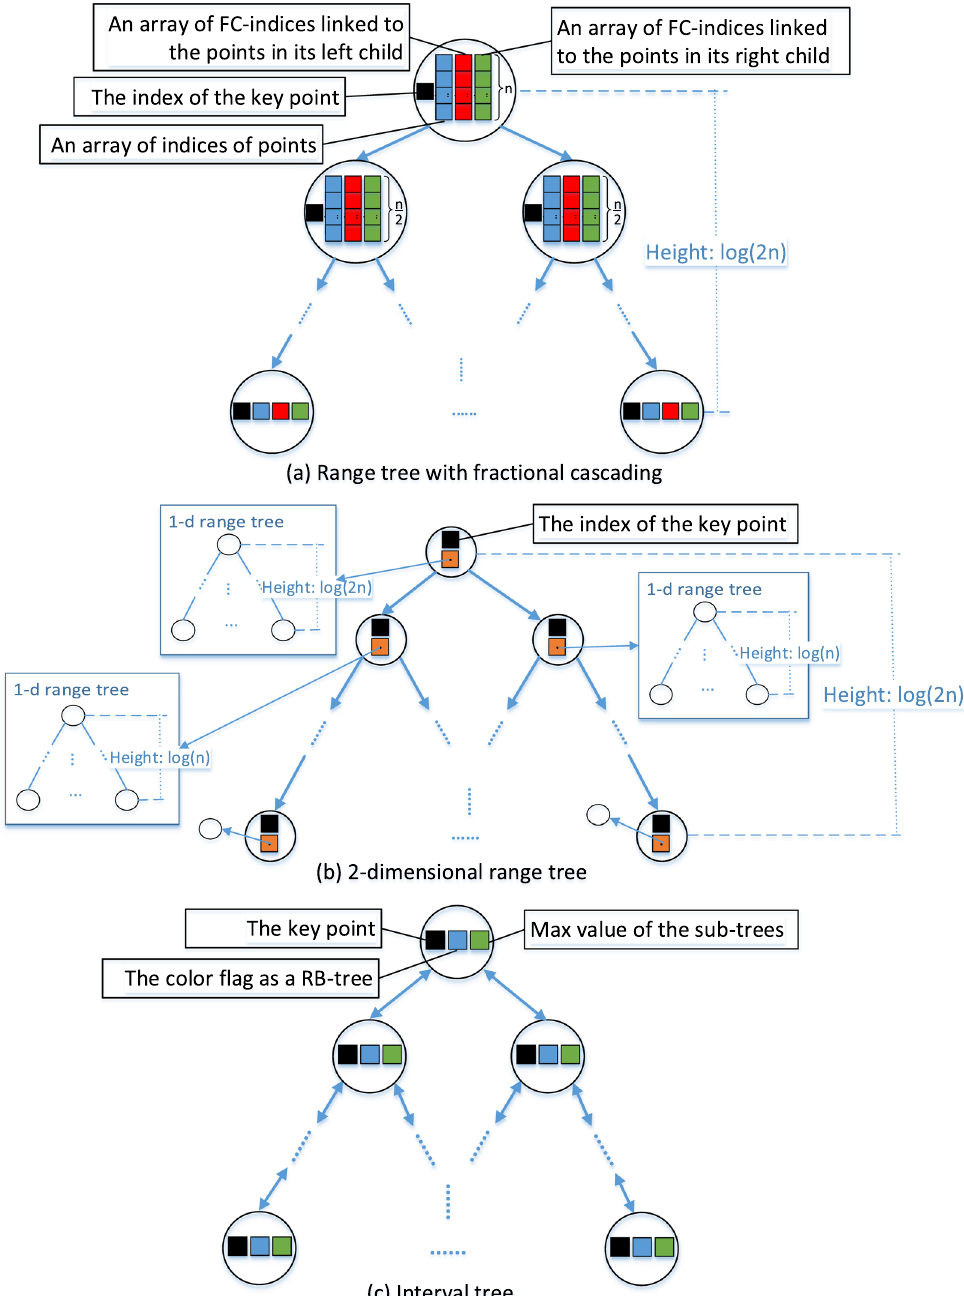
corresponding arrows between nodes. ( a ) The data structure of range tree with fractional cascading (RTFC). ( b ) The data structure of the basic 2-dimensional range tree (2D-RT). ( c ) The data structure of interval tree (IT) implemented as an augmented RB-tree (red-black tree) with n